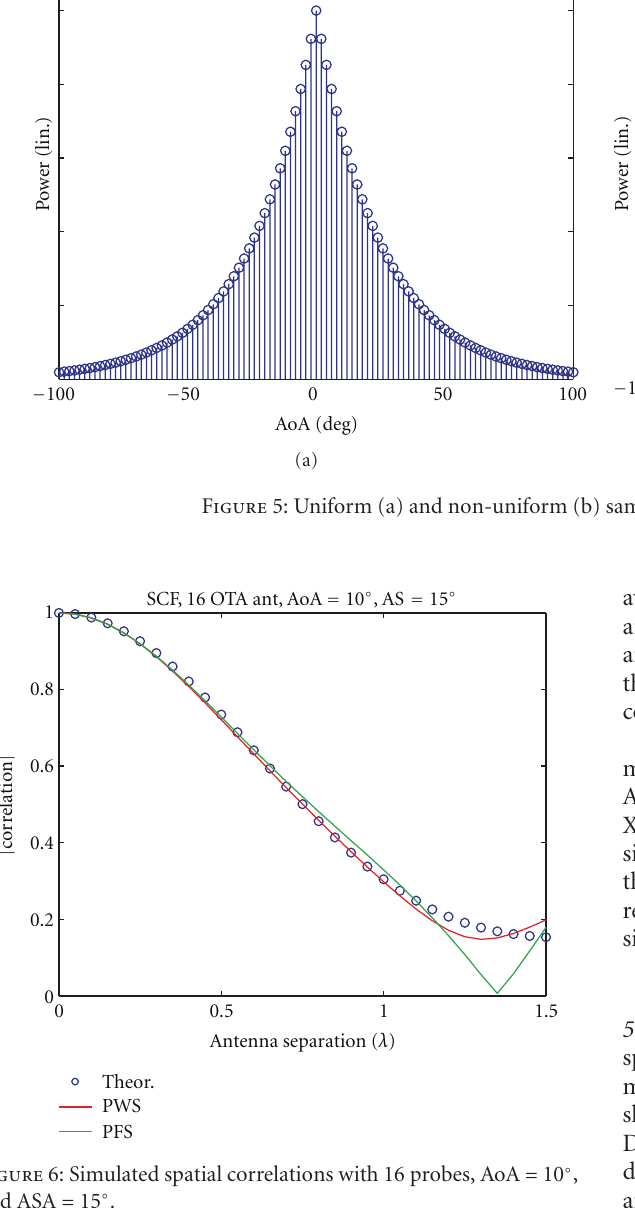
Figure 6: Simulated spatial correlations with 16 probes, AoA = 10 ◦ , and ASA = 15 ◦